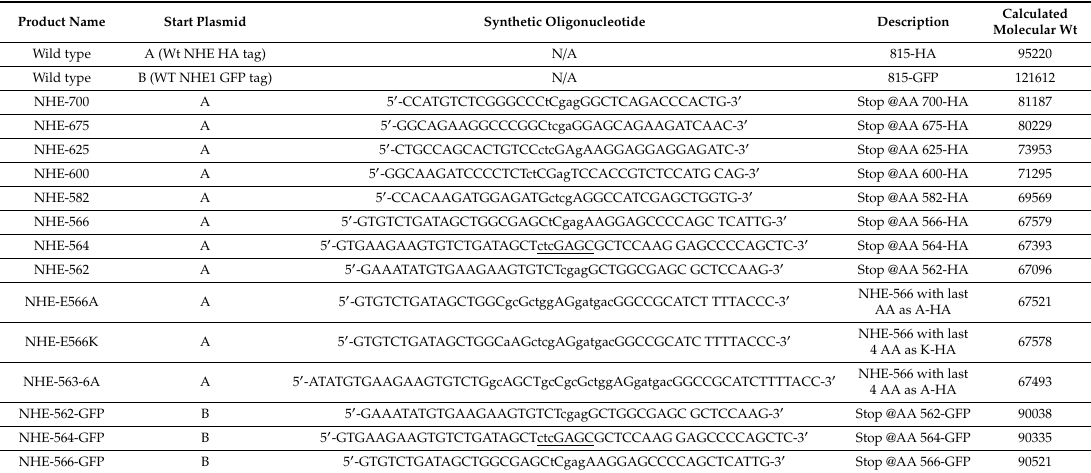
Table 1. Oligonucleotides that were used for site specific mutagenesis. Lowercase indicates altered bases. Only the forward primer is